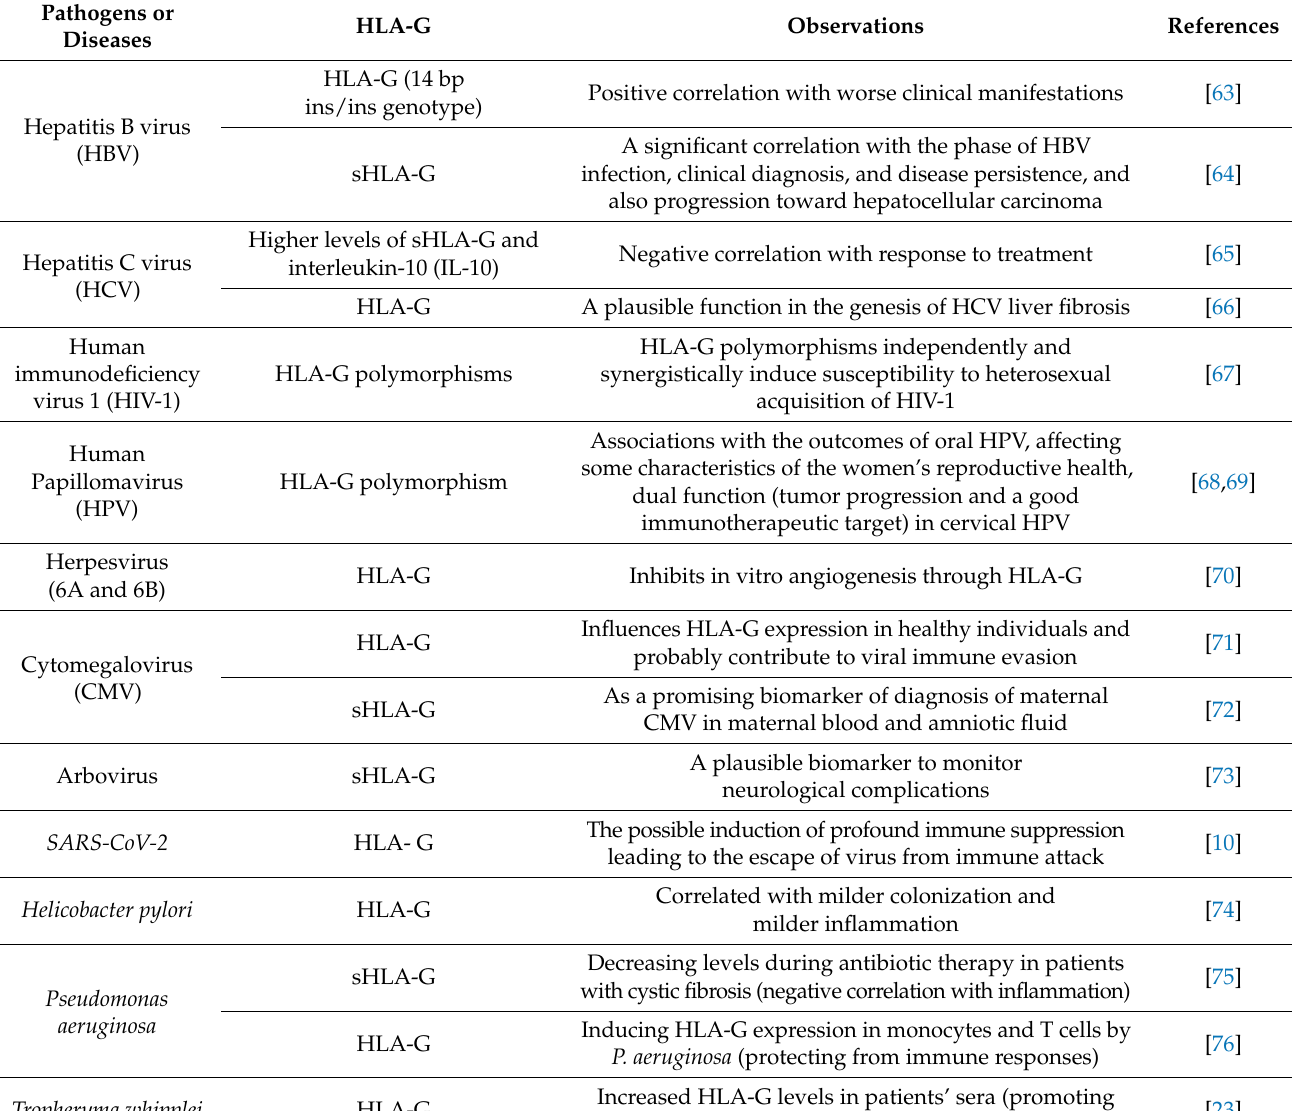
Table 1. The correlation of HLA-G with infectious diseases caused by viruses, bacteria, and proto- zoan